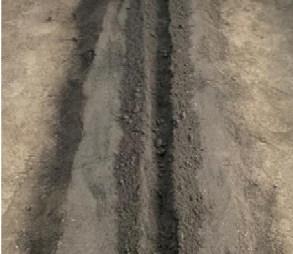
Figure 12. Soil bin experiment furrow .